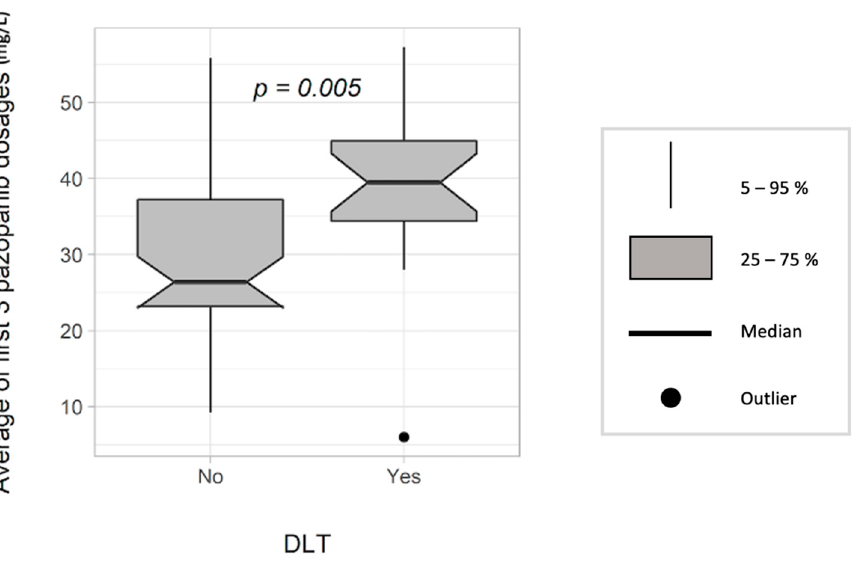
Figure 4. Dose-limiting toxicities (DLT) according to the average of the first three trough (C min ) con- centrations of pazopanib (n = 95). concentrations of pazopanib (n =